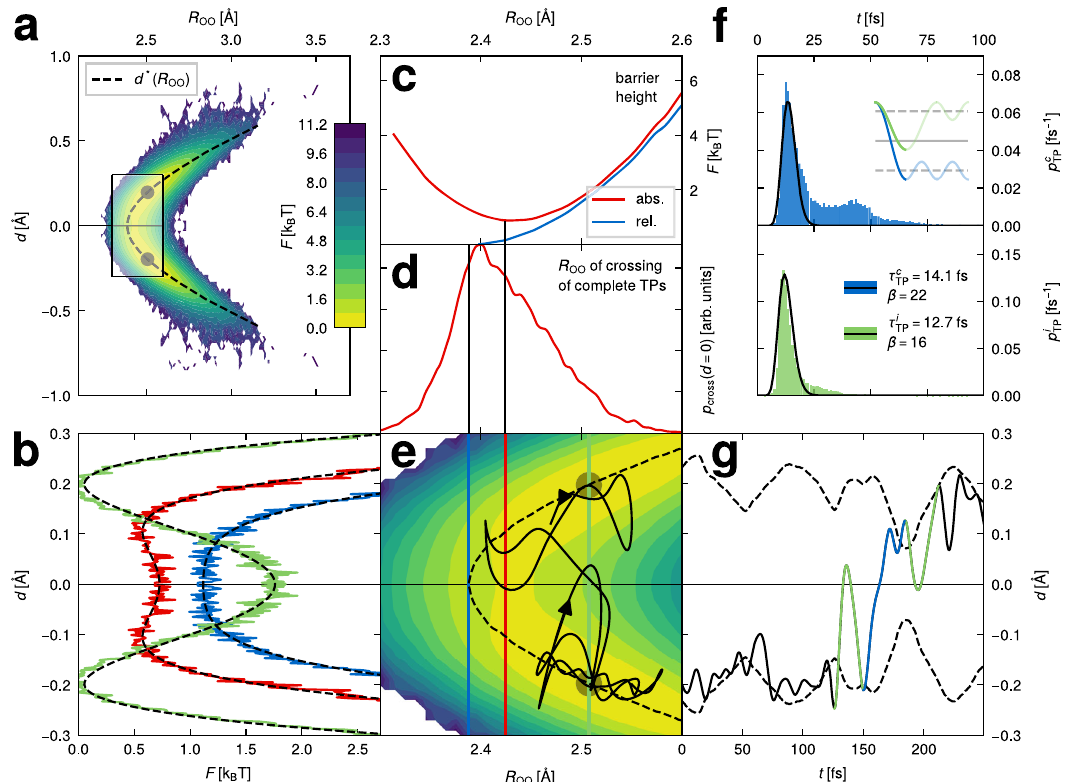
Fig. 4 2D excess-proton trajectory analysis. a The two-dimensional (2D) free energy of the excess protons in 6 M HCl solution for the ( d , R OO ) coordinates de fi ned in the inset of Fig. 3a. The shaded area is enlarged and shown in e. The gray dots denote the positions of the global minima of the 2D free energy. The minima for fi xed R OO , i.e., the most likely proton locations, d * ( R OO ), are indicated by a black broken line. b Cuts through the free energy in a for R OO = 2.39 Å , where the barrier just vanishes (blue solid line), R OO = 2.42 Å , where the absolute barrier height is minimal (red solid line) and R OO = 2.51 Å , for which the global minima of the 2D free energy are obtained (green solid line). c The absolute free energy at d = 0 (red solid line) and the barrier height relative to the minima at fi xed R OO located at d * ( R OO ) (blue solid line). d Distribution of R OO positions at which complete transfer paths cross the d = 0 midplane. e Zoom into the free energy shown in a. The vertical colored lines indicate the cuts through the free energy shown in b. An example trajectory from the ab initio molecular dynamics (MD) simulation is shown as a black solid line. f Path-duration distributions of complete (blue, times de fi ned from d * to − d * ) and incomplete transfer paths (green, times de fi ned from d * to d = 0). Fits according to Eq. (1) are shown as black solid lines. g Time course of the example trajectory along d , same as shown in e, with complete and incomplete transfer paths indicated as blue and green lines, respectively. The two branches of the R OO -dependent minimal energy position d * [ R OO ( t )] are shown as black broken of R OO and are determined by the parabolic function d * ( R OO ), which is plotted as a black broken line in Fig. 4a, e. The cuts in Fig. 4b are shown for R OO = 2.39 Å , where the barrier just vanishes (blue solid line), R OO = 2.42 Å , where the absolute barrier height is minimal and which contains the transition state in the d - R OO plane at d = 0 (red solid line), and R OO = 2.51 Å , which contains the global minima of the 2D free energy (green solid line). R OO , a blow up of the shaded area is given in Fig. 4e. By de fi - nition, the free energy is symmetric with respect to the midplane at d = 0, which separates two global minima at R OO = 2.51 Å and d = ±0.2 Å . These minima, highlighted as gray dots in Fig. 4a, correspond to states where the excess proton is asymmetrically shared between the two fl anking water molecules. The transition between these minima, i.e., the proton transfer, is, therefore, a barrier-crossing process in the two-dimensional plane spanned by R OO and d . Figure 4b shows cuts through the free energy for constant R OO along d , each fi tted to a quartic expression F ( d ) = F d = 0 (1 + γ 2 + γ 4 ) shown as black broken lines. Details are reported in 2 d 4 d Supplementary Methods 3. For negative γ 2 , two minima at d (cid:3) ¼ p ffiffiffiffiffiffiffiffiffiffiffiffiffiffiffiffiffiffiffiffi = ð 2 γ Þ (cid:4) γ are separated by a barrier at d = 0, which ± 2 4 correspond to the optimal proton asymmetry for a given value